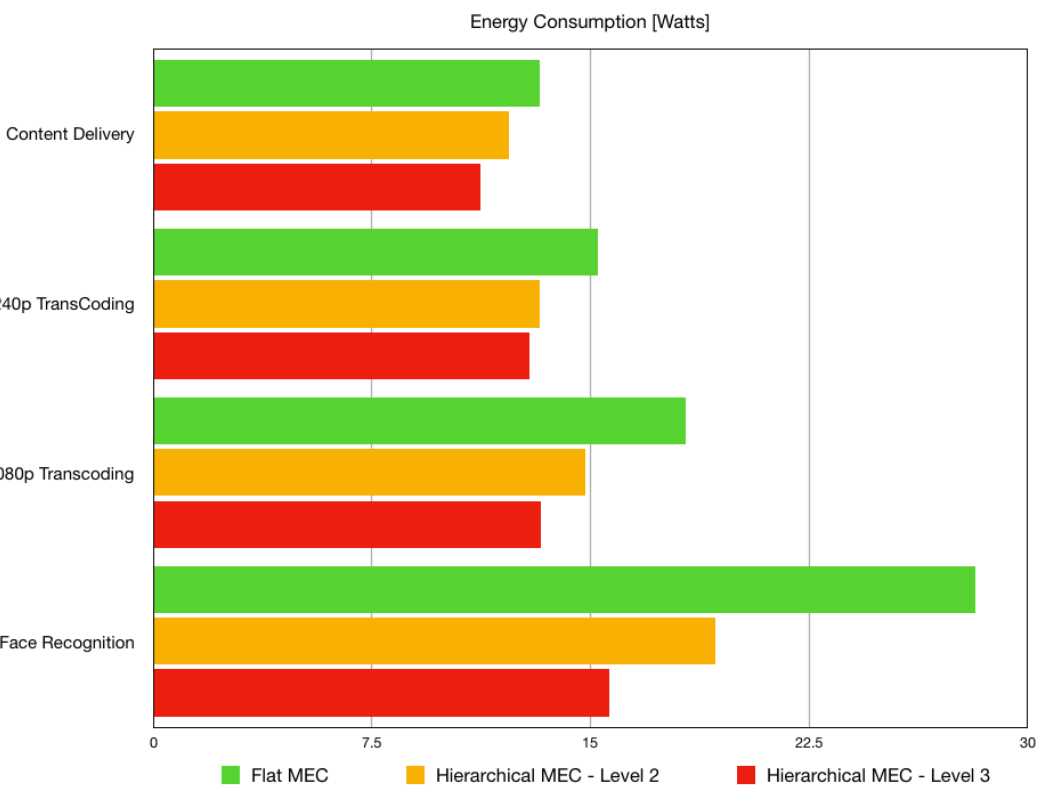
Figure 11. The energy consumption of different types of computing